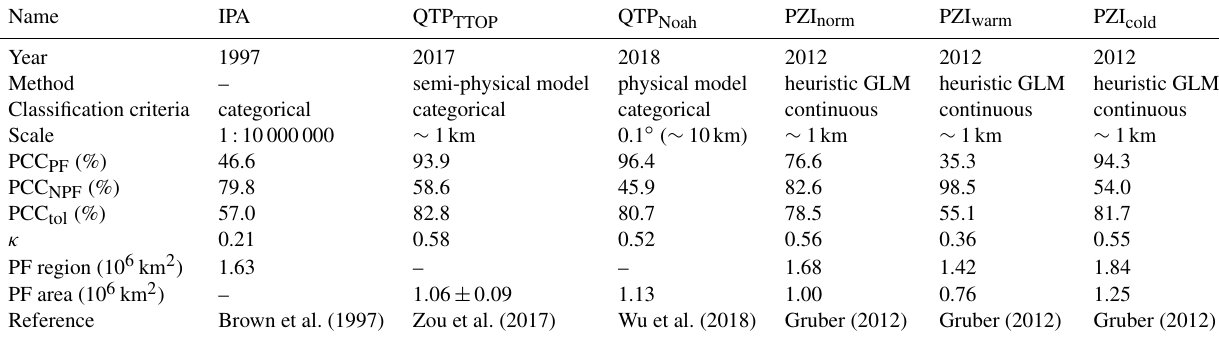
Table 2. Summary and evaluation of existing permafrost maps over the Qinghai–Tibet